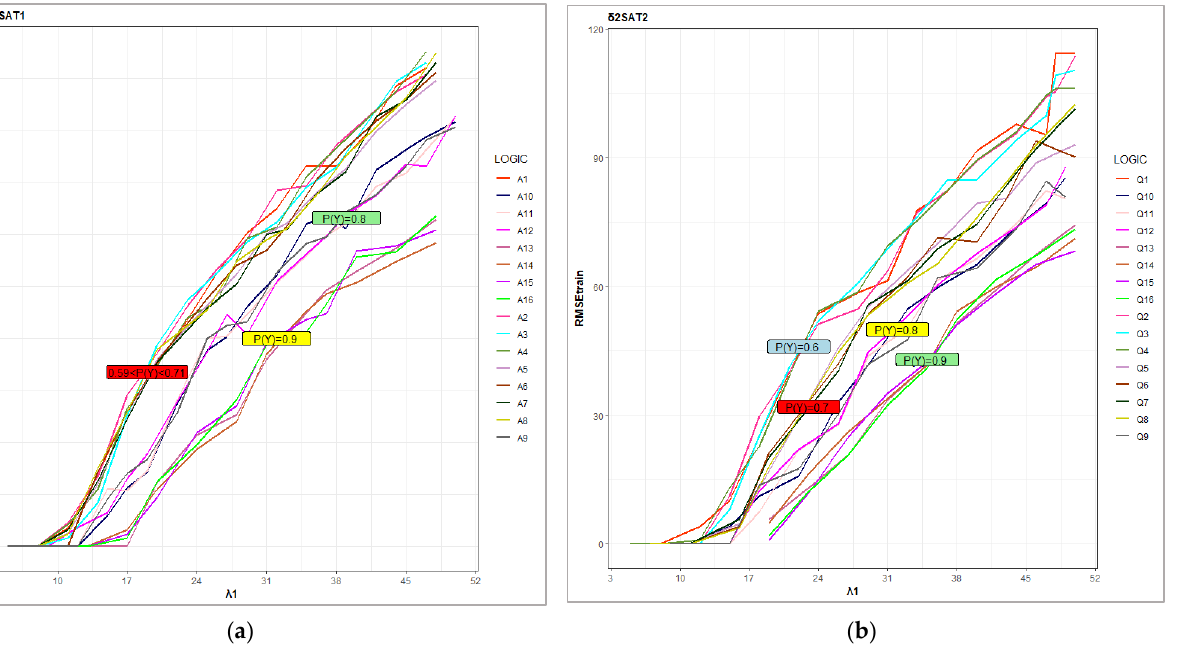
1 2 SAT ρ , ( b ) δ 2 2 SAT ρ